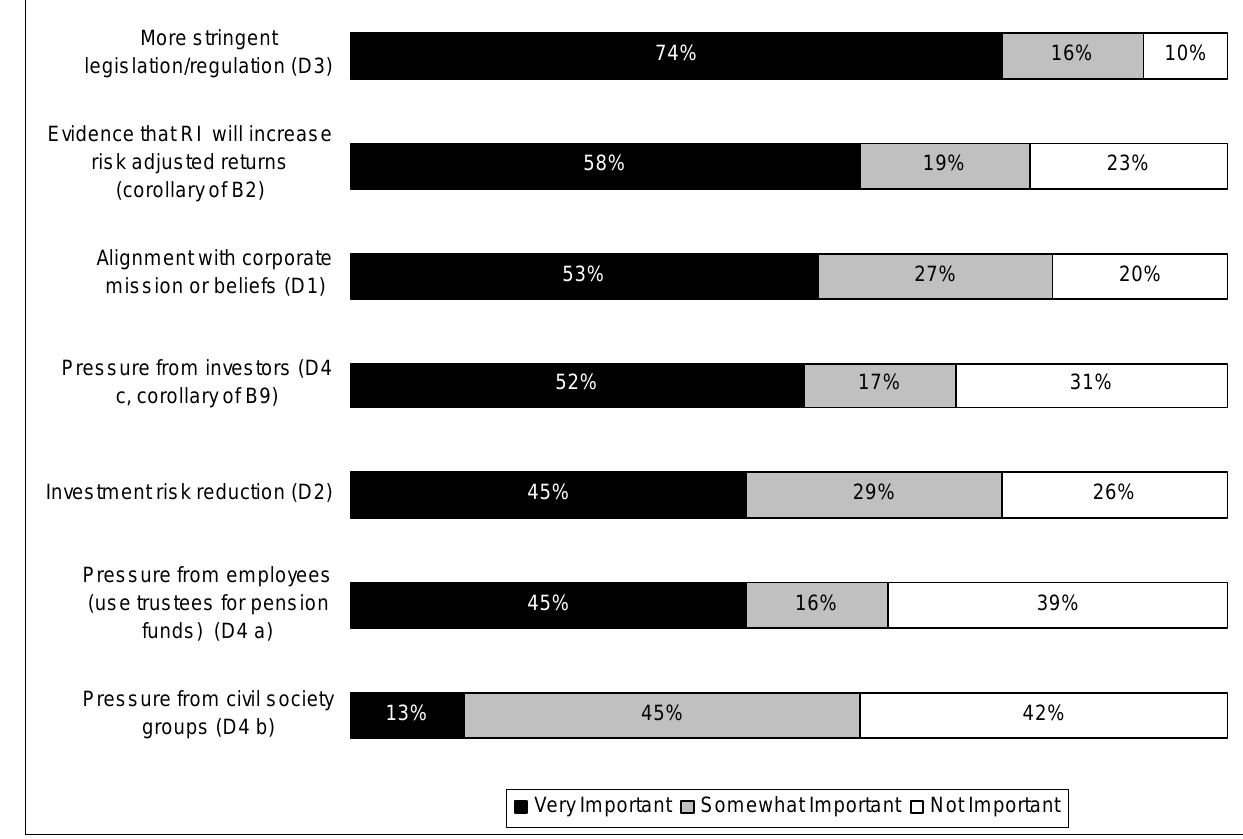
Figure 4: Pension funds - Drivers of